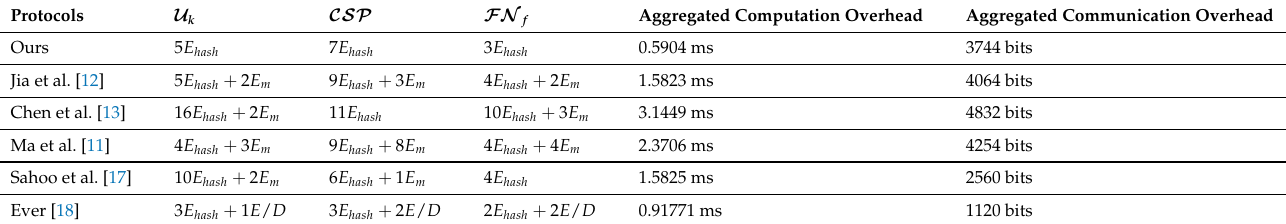
Table 5. Comparison of computation and communication overhead.